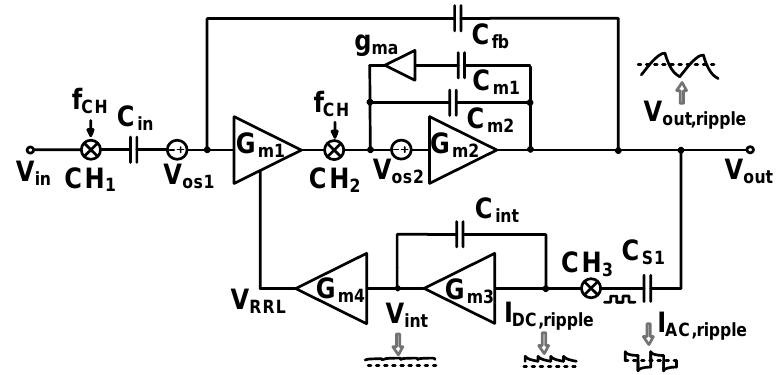
Figure 11. Schematic showing the operation of the ripple-reduction loop.